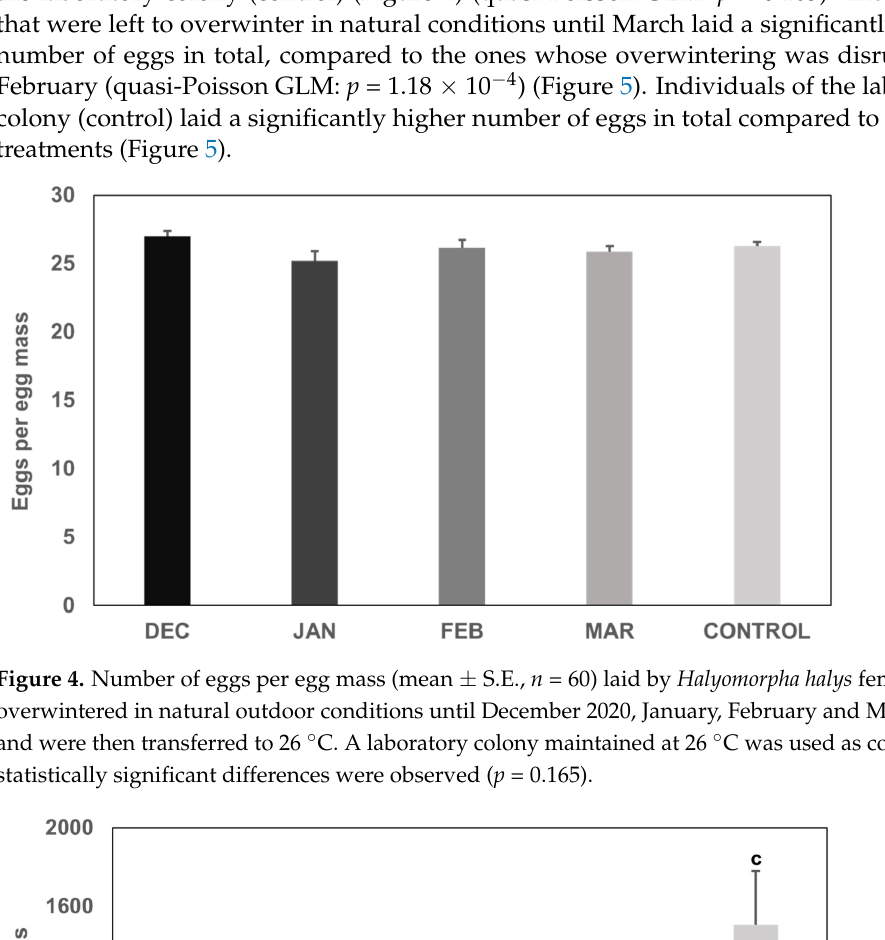
Figure 3. Preoviposition period (mean ± S.E., n = 60) of Halyomorpha halys females that overwin- tered in natural outdoor conditions until December 2020, January, February and March 2021 and were then transferred to 26 °C. A laboratory colony maintained at 26 °C was used as control. Differ- ent letters above bars indicate statistically significant differences ( p < 0.001).